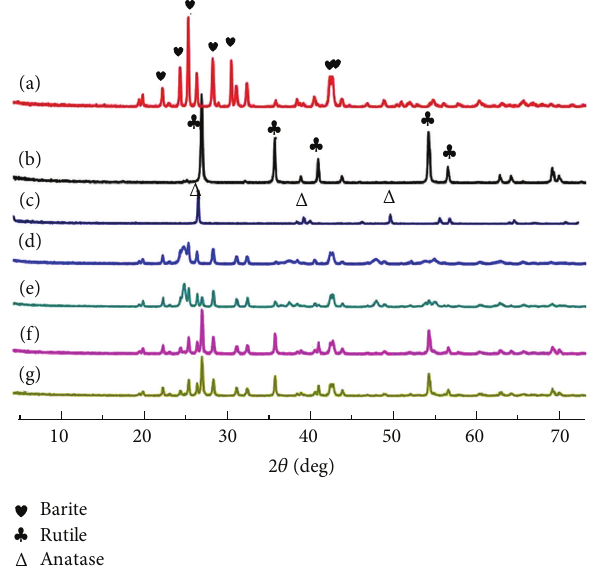
Figure 4: XRD patterns of the naked barite (a), rutile TiO 2 (b), anatase TiO 2 (c), and barite coated with TiO 2 powders ((d), (e), (f), and (g)) calcined at 600, 700, 750, and 800 ∘ C for 1 h. was shown that the bands of B/TCP at 883 cm −1 , 728 cm −1 , and 1440 cm −1 disappeared. Deducing from the above phe-